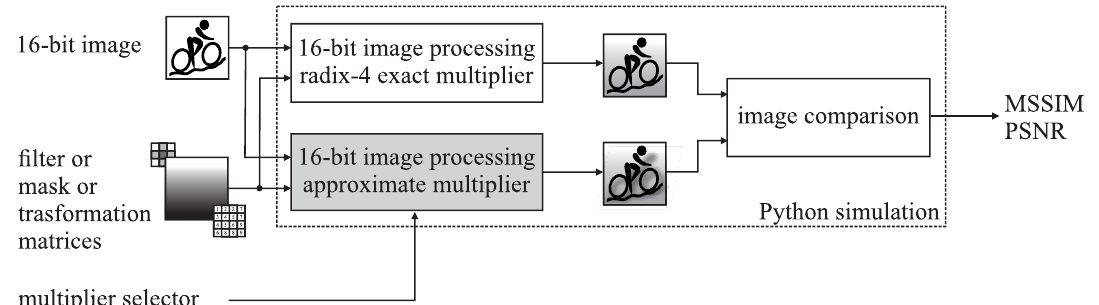
Figure 7. Workflow for multiplier comparison in image